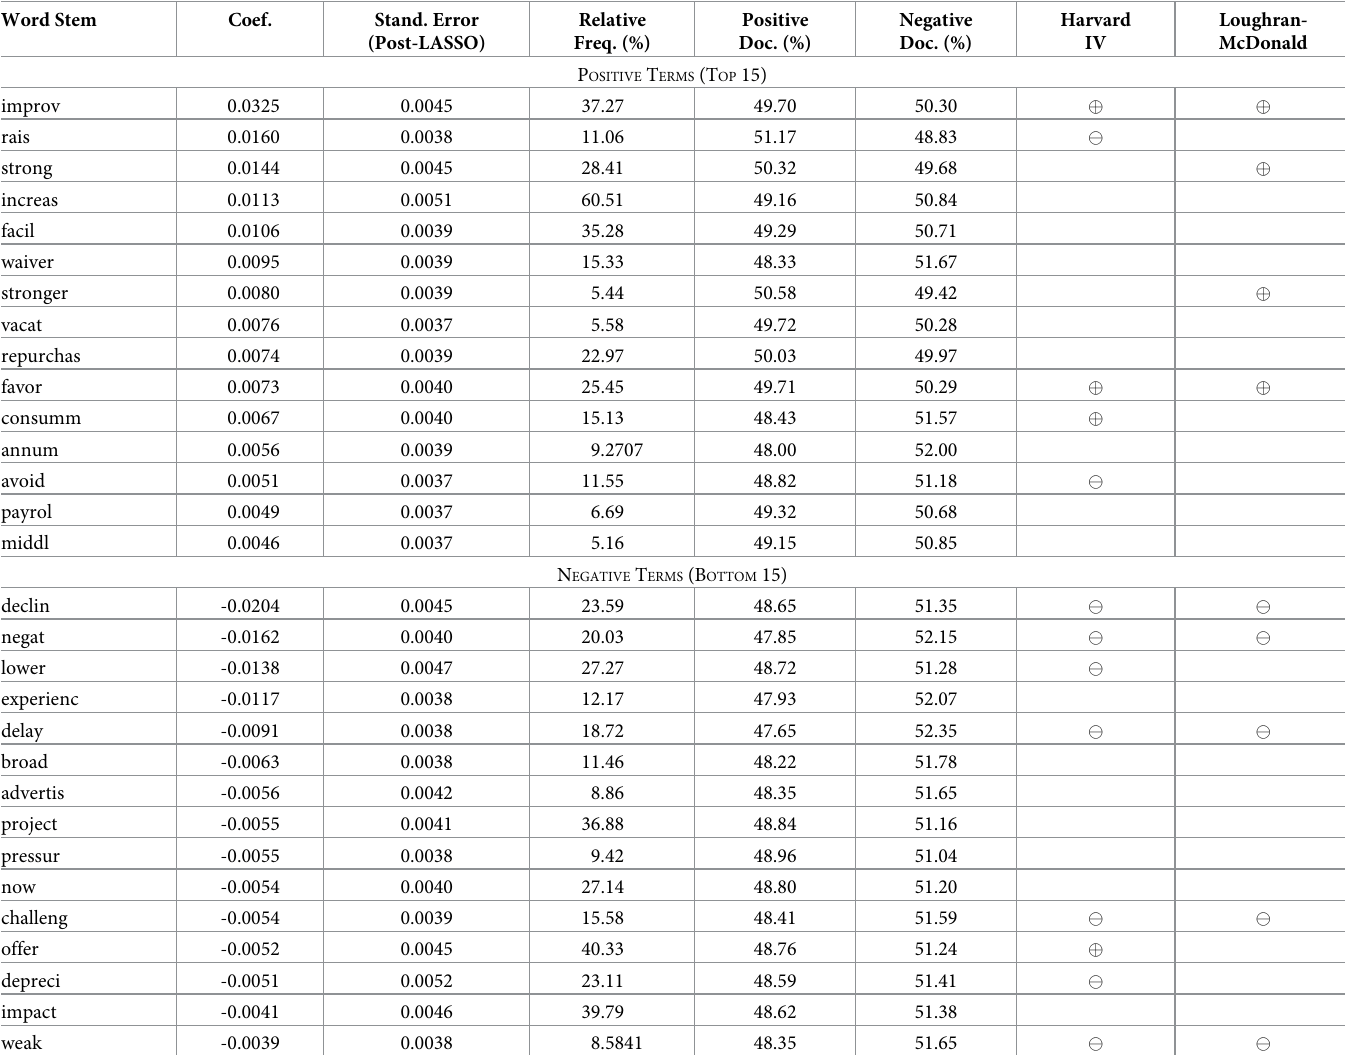
Table 3. Empirical results of top 15 polarity expressions in financial filings. Word